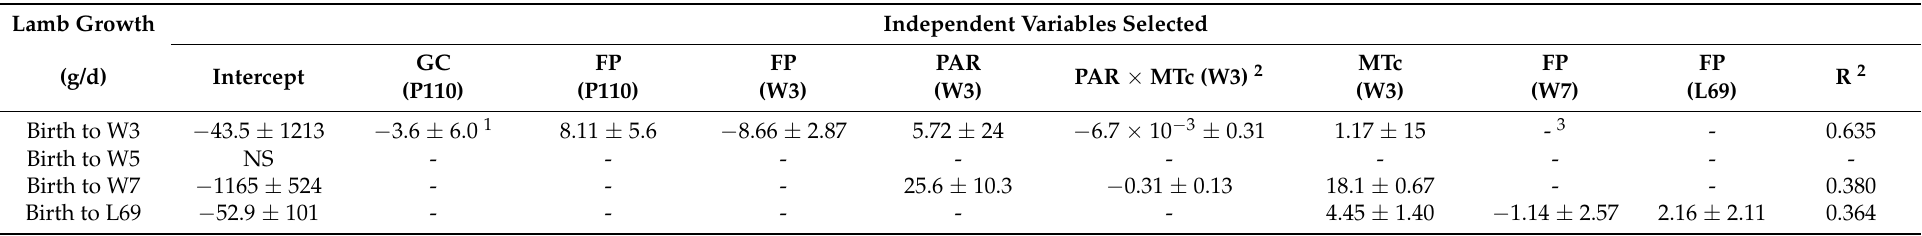
Table 8. Multiple regression coefficients ( ± s.e.m.) of the average of ultrasound (GC, PAR, FP and MTc) measurements in pregnancy (P110), week 3 (W3), 5 (W5) and 7 (W7) of lactation on single lamb growth from birth to week 3 (Birth to W3), birth to week 5 (Birth to W5), birth to week 7 of lactation (Birth to W7) and birth to weaning (Birth to L69). Lamb Growth Independent Variables